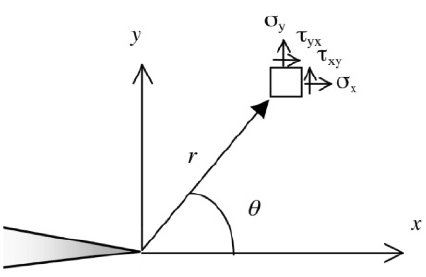
Figure 3. Basic usage of linear elastic fracture mechanics method [16].